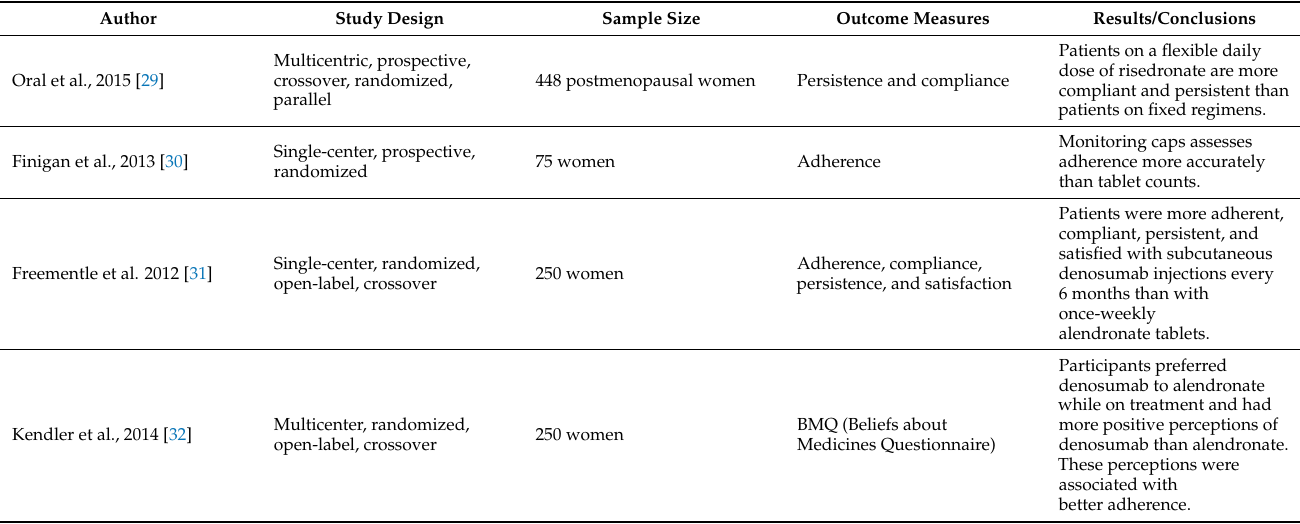
Table 3. Characteristics of Studies analyzing different drug